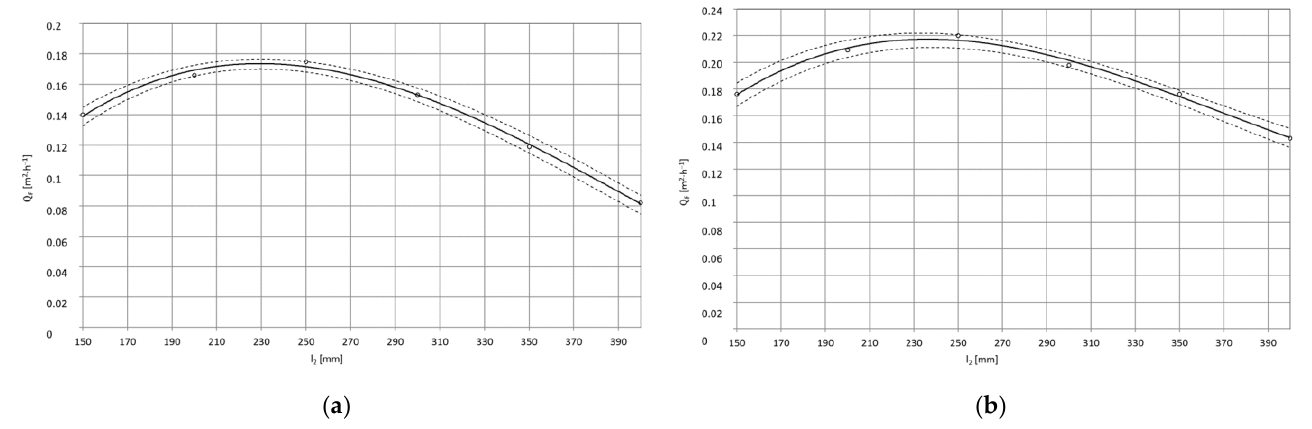
Figure 14. Influence of jet working length l 2 [mm] on maximum surface efficiency Q ̅ high-pressure water-ice jet paint coat stripping from PA2 aluminium alloy surface (TS = 4 × 1.2 mm, L k =200 mm, κ = 90°,  ṁ L = 156 kg·h  1 ): ( a ) Jet pressure p w = 20 MPa; ( b ) p w =35